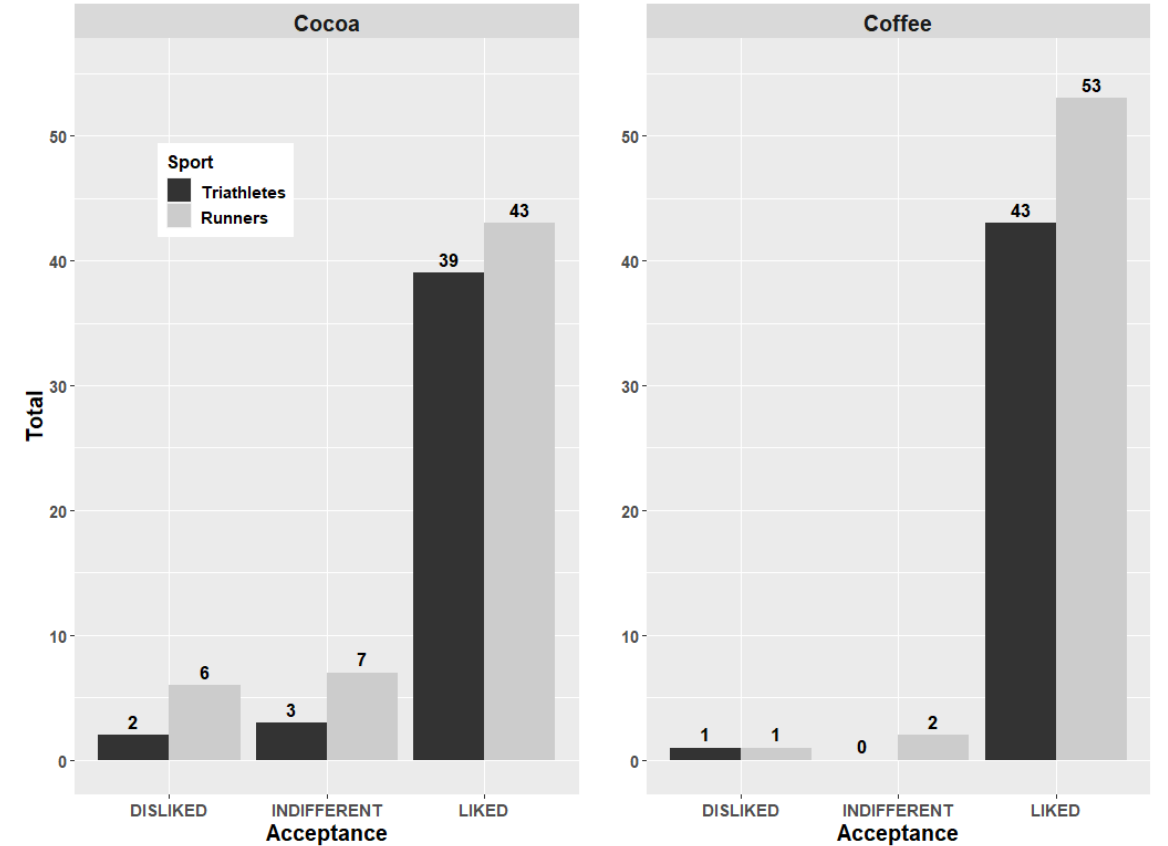
Figure 1. Total acceptance by triathletes and runners for Cocoa and Coffee beverages.